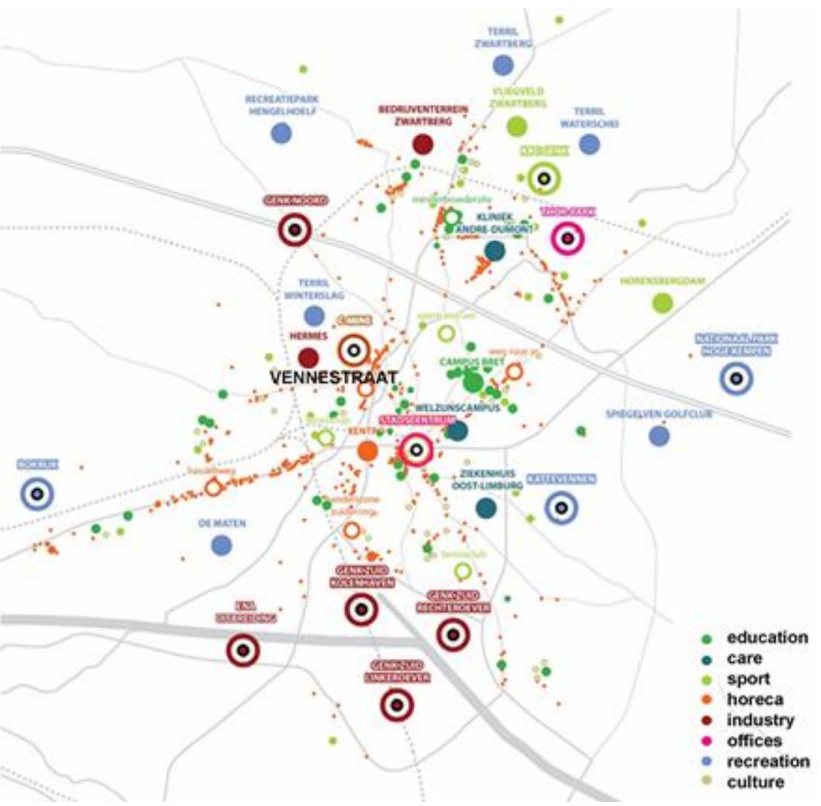
Figure 2. Vennestraat street and the city landmarks. Source: Rapport Rasterstad Genk, BUUR,